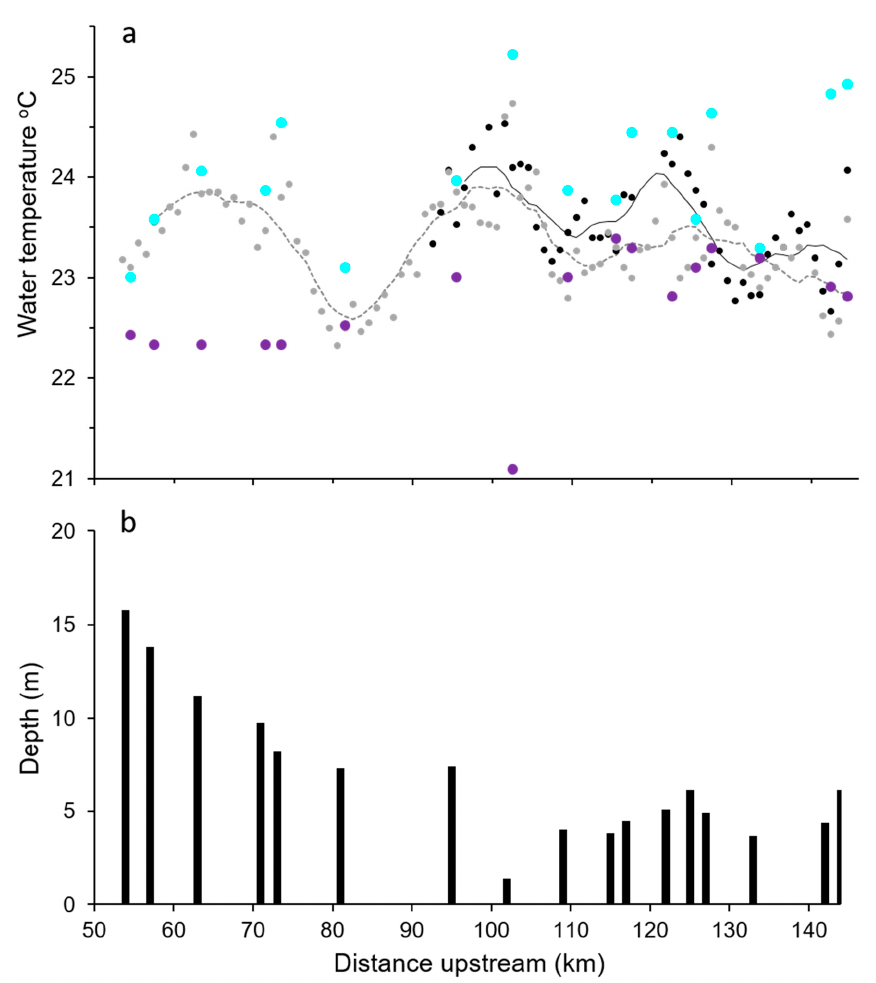
Figure 2. Longitudinal thermal profile of the Pend Oreille River based on airborne thermal infrared (16 August 2001) and instream (22 August 2017) temperature data ( a ). Black circles and gray circles represent radiant water temperature for the right and left banks, respectively. Dotted and smoothed lines are 10-km centered moving averages. Purple circles and cyan circles represent bottom daily maximum water temperature and surface daily maximum water temperature, respectively. Water depth at deployment for all instream water temperature main stem sites (b). The median radiant temperatures were 23.4 °C for the right bank and 23.6 °C for the left bank, with standard deviations of ±0.50 and ±0.48, respectively. We found that the 22 August 2017 instream surface water temperature lowest trough and highest peak coincided with the TIR lowest trough and highest peak. The lowest TIR trough was 22.3 °C and was located near river kilometer (rkm) 80 in a